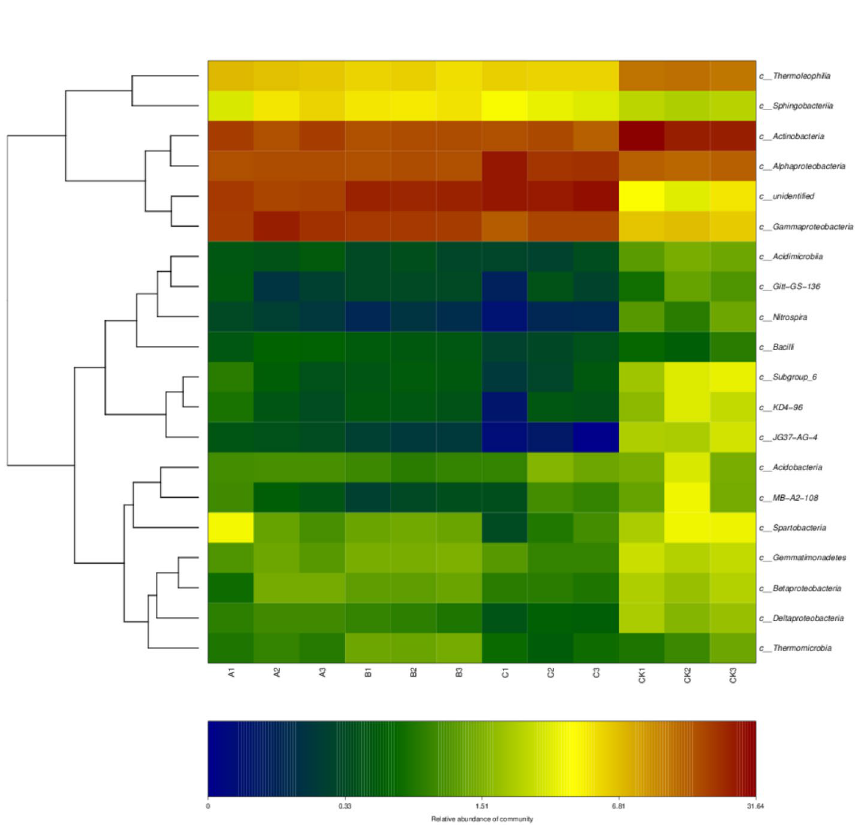
Figure 6. Abundance thermogram and cluster map of the top 20 samples at the class level. Created using Mothur1.43.0 software (http:// mothur. org). Here, only the heatmap of OTUs of TOP20 and their gate levels are shown. The horizontal axis represents samples at different points, the vertical axis represents OTUs of different points, and the depth of color represents the